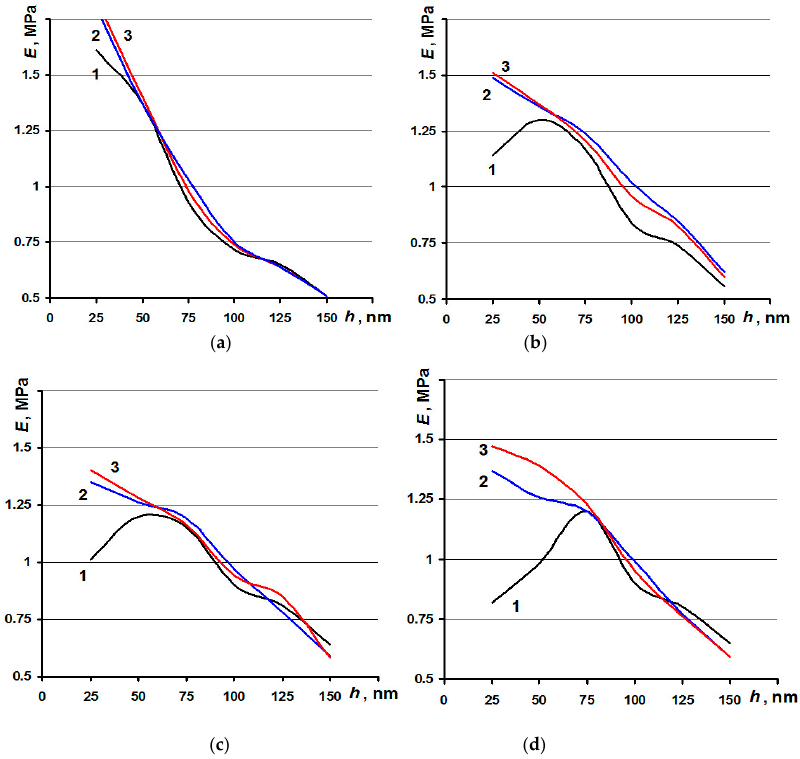
Figure 5. Relationships between Young’s modulus and the indentation depth: ( a ) healthy, ( b – d ) three stages of wear by osteoarthrosis (OA): ( b ) 49.0 nm < Ra < 61.2 nm; c ) 36.8 nm < Ra < 49.0 nm; and ( d ) 24.6 nm < Ra < 36.8 nm): 1) cartilage surface layer; 2 and 3) subsurface layers after the first and second cross-sections. ( d ) 24.6 nm < Ra < 36.8 nm): (1) cartilage surface layer; (2 and 3) subsurface layers after the first and second